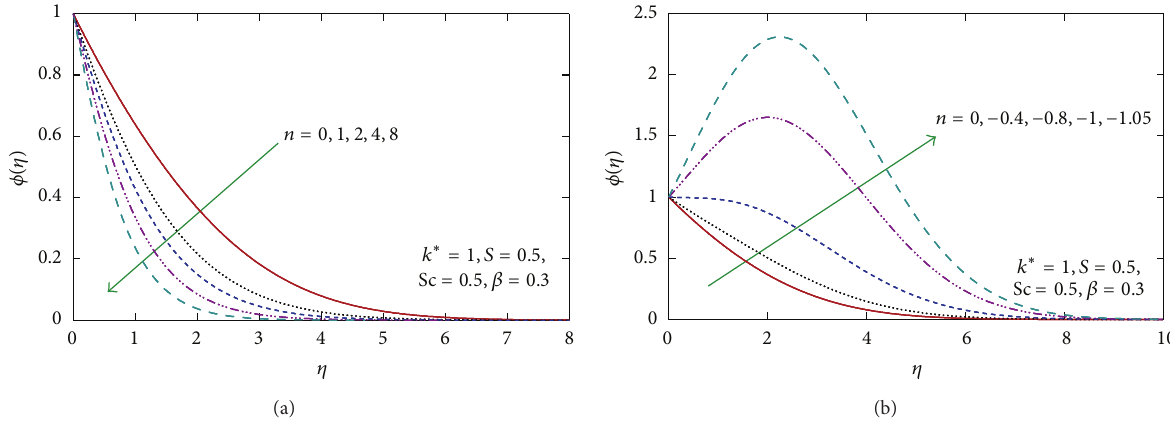
Figure 8: (a) Concentration profiles 𝜙(𝜂) for different values of 𝑛(> 0) . (b) Concentration profiles 𝜙(𝜂) for different values of 𝑛(< 0) .